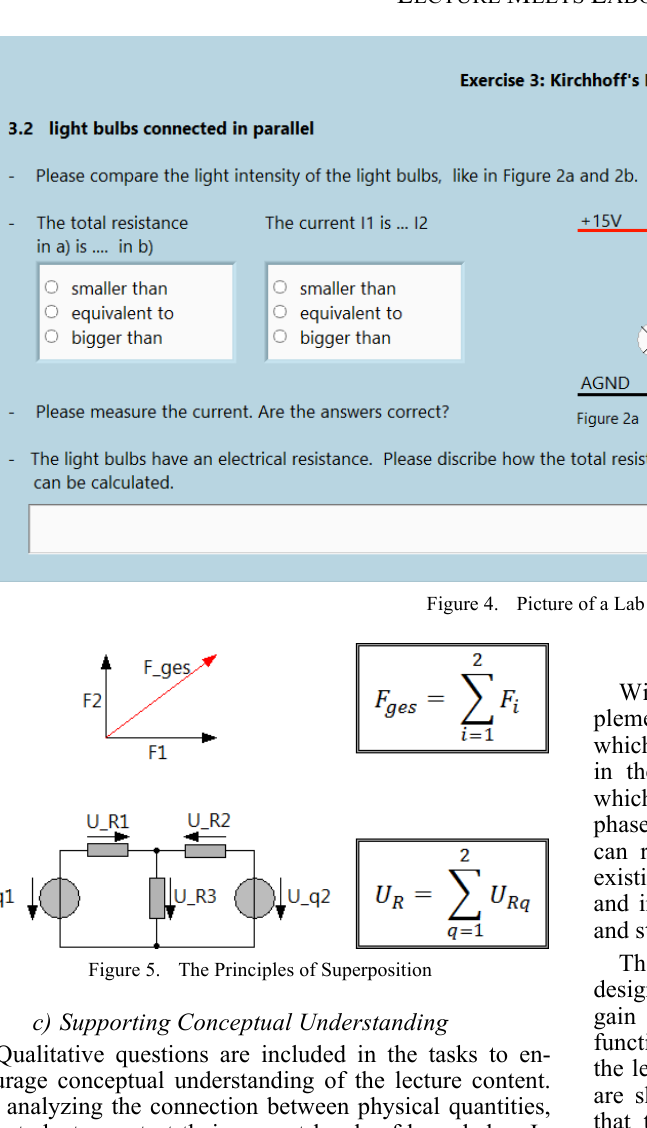
Figure 5. The Principles of